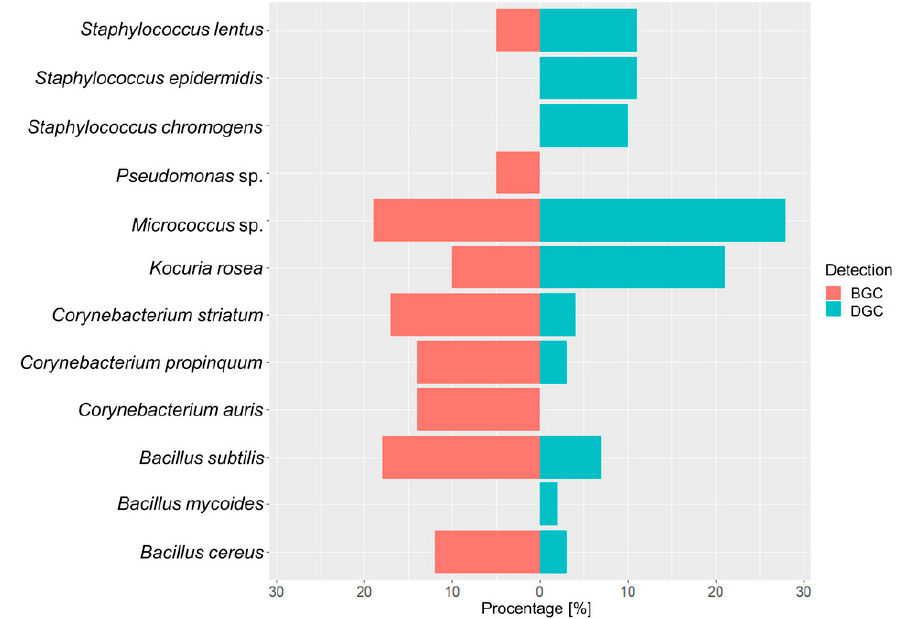
Figure 2. The most frequent BA species identified in a highschool gym before gym classes (BGC) and during gym classes